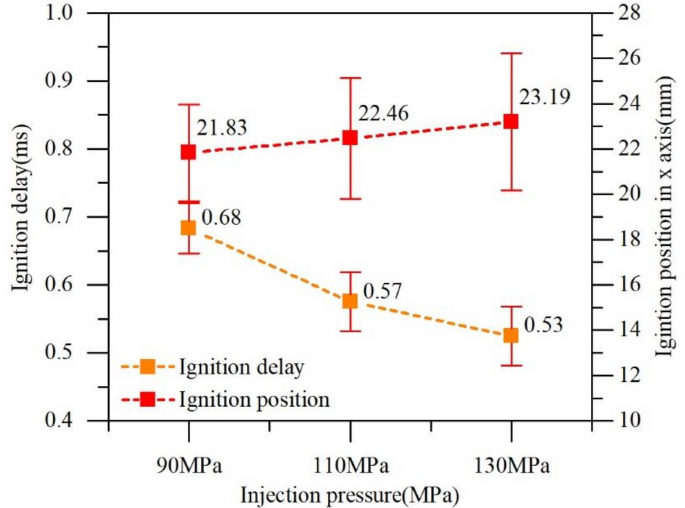
Figure 10. The axial initial ignition position and ignition time